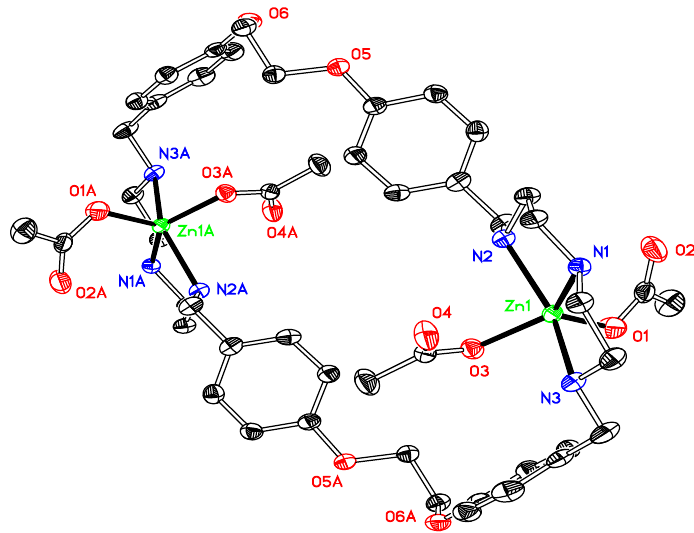
Figure 3. Thermal ellipsoid plot, drawn at the 50% probability level, of [Zn 2 (OCOCH 3 ) 4 L 1 ] ( 3 ) with atomic numbering scheme. All H atoms, along with DMFs and waters are omitted for clarity. Symmetry codes: A 1 − x, − 1 − y, − z. Selected bond lengths (Å) and angles ( ◦ ): Zn1–N1 2.0968(14), Zn1–N2 2.218(14), Zn1-N3 2.2024(14), Zn1-O1 1.9456(13), Zn1-O3 2.0184(13); N1–Zn1–N2 80.46(5), N2–Zn1–N3